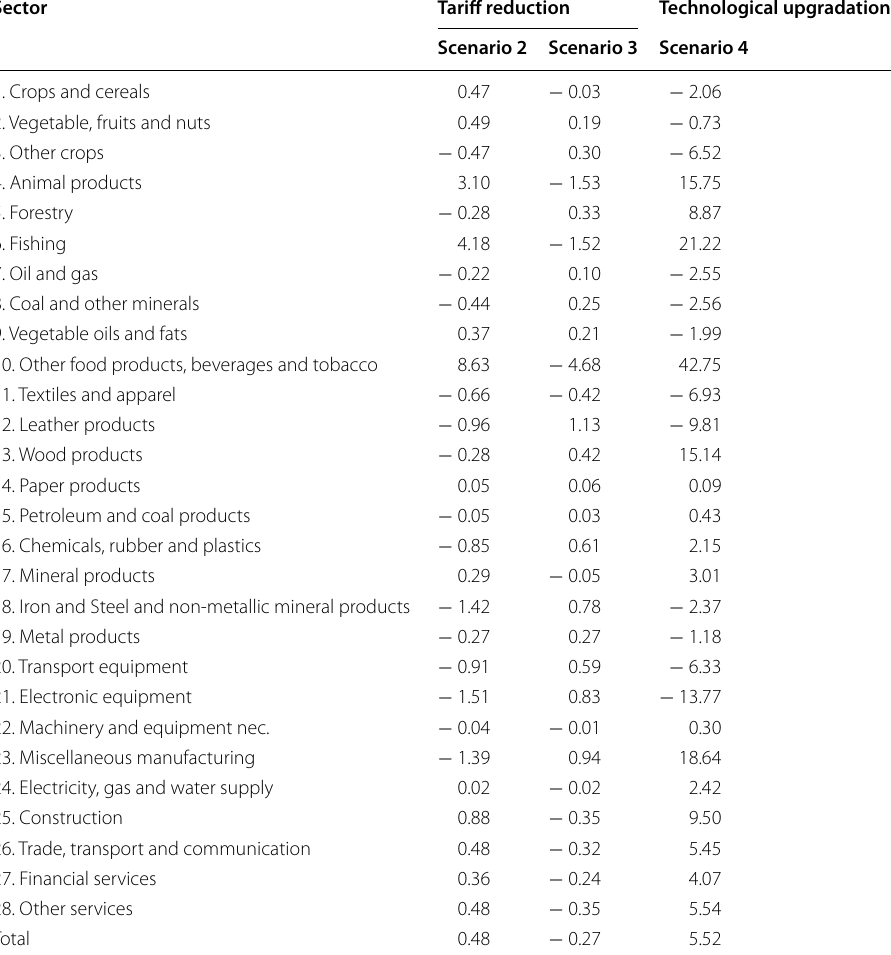
Table 2 Sectoral output growth due to tariff simulation and technological upgradation at 2030 compared to BAU 2030 (with USA as TPP